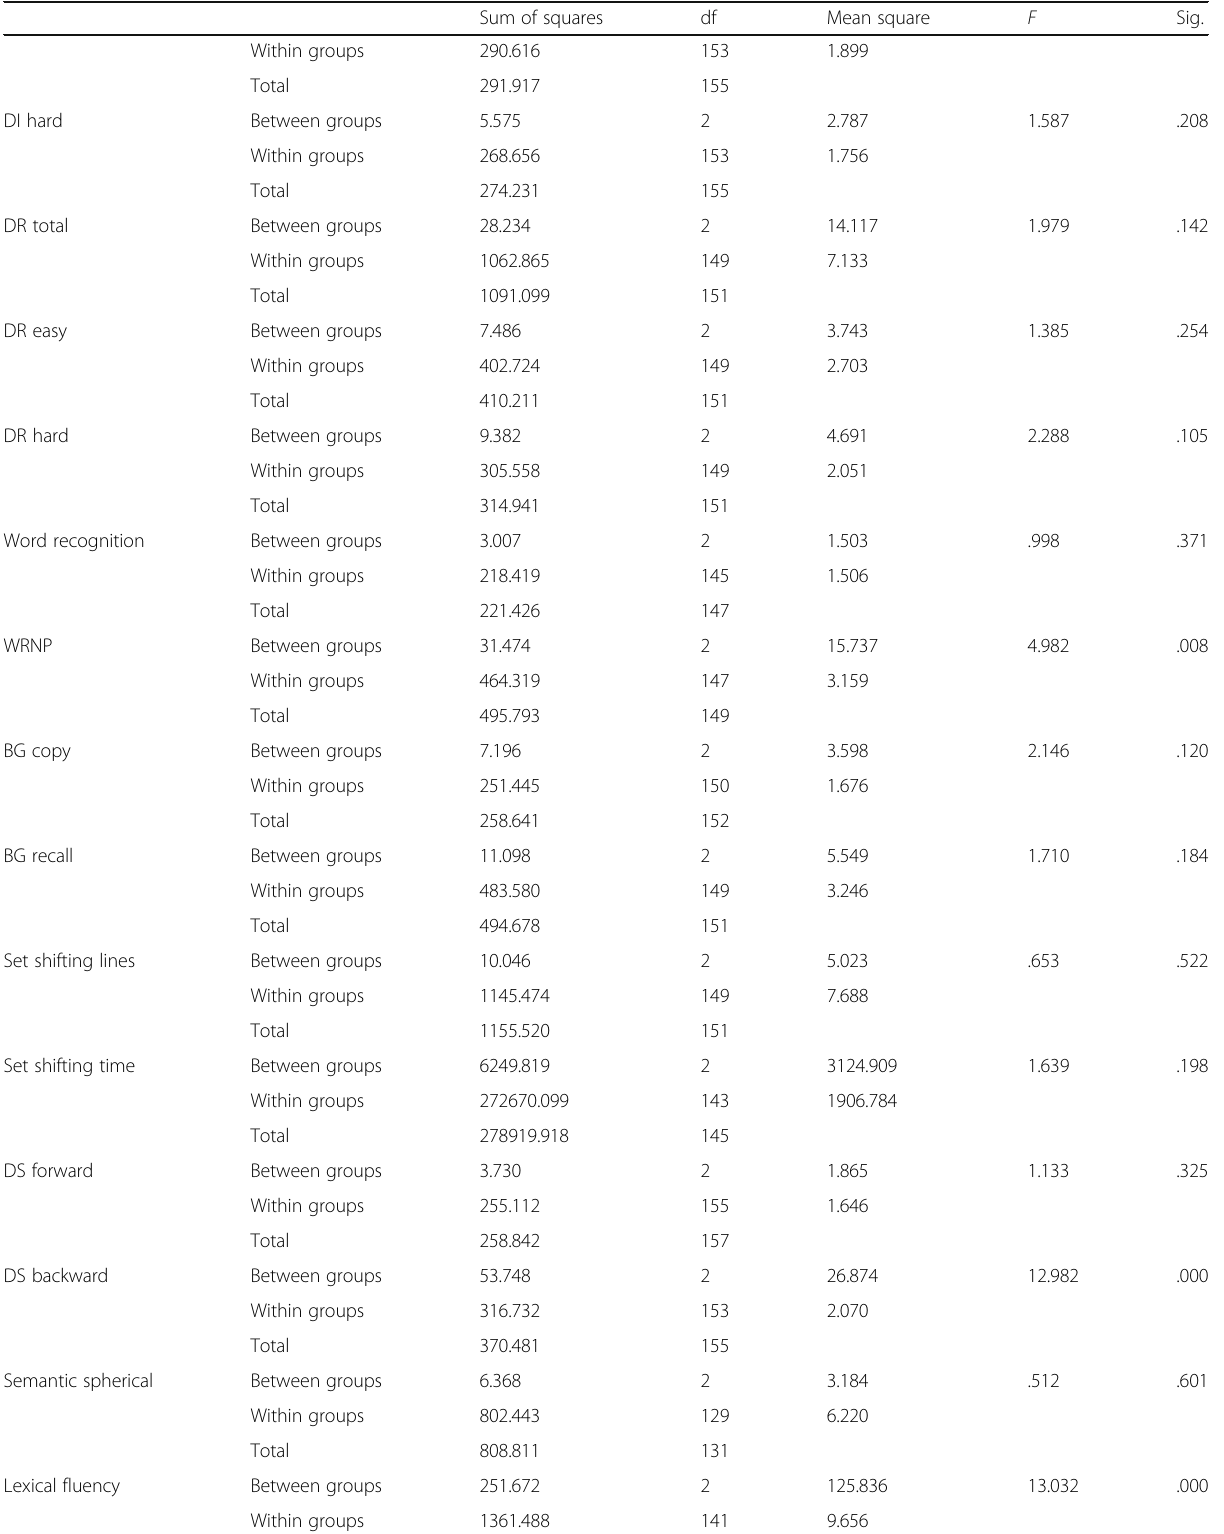
Table 5 Significant F test between Groups as regards education (Continued)